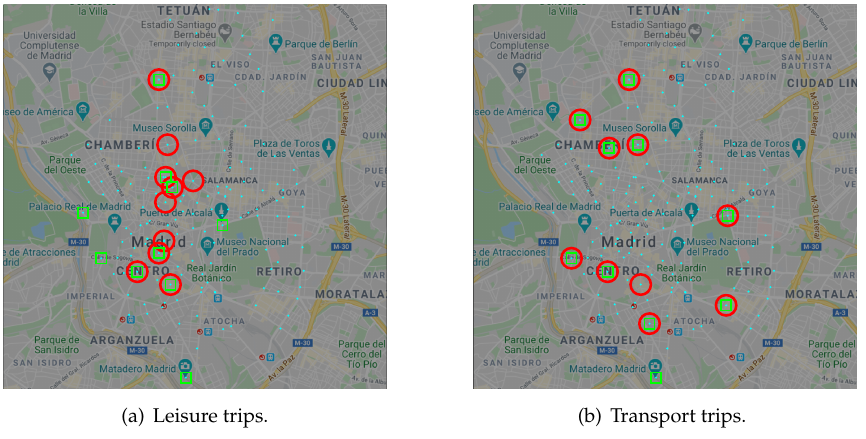
Figure 4. Main origins (red circles) and destinations (green squares) of